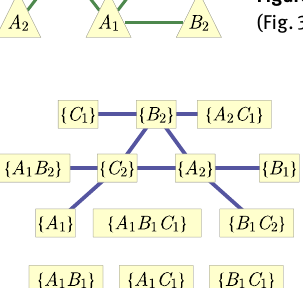
Figure 9: The injection graph corresponding to the Spiral inflation of the Triangle scenario (Fig.3), wherein the cliques are the injectable sets.